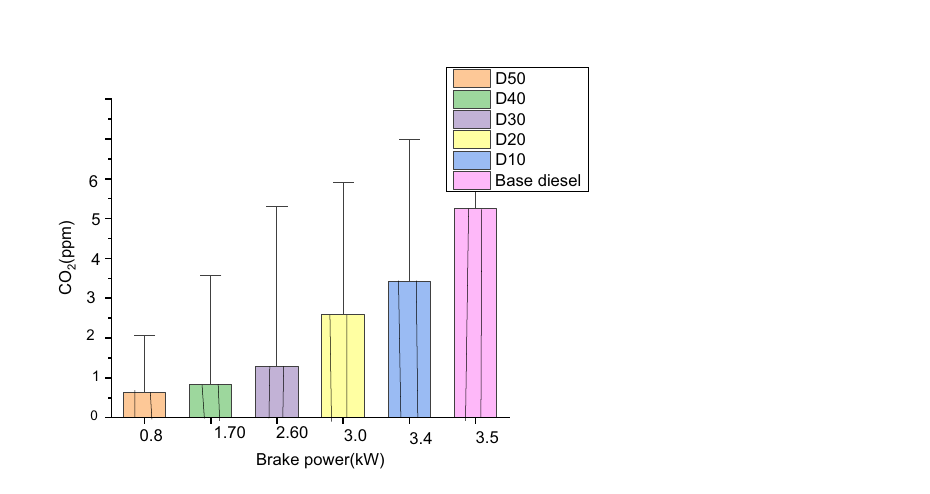
Figure 9. Comparison of the oxide of nitrogen emissions of various blends.